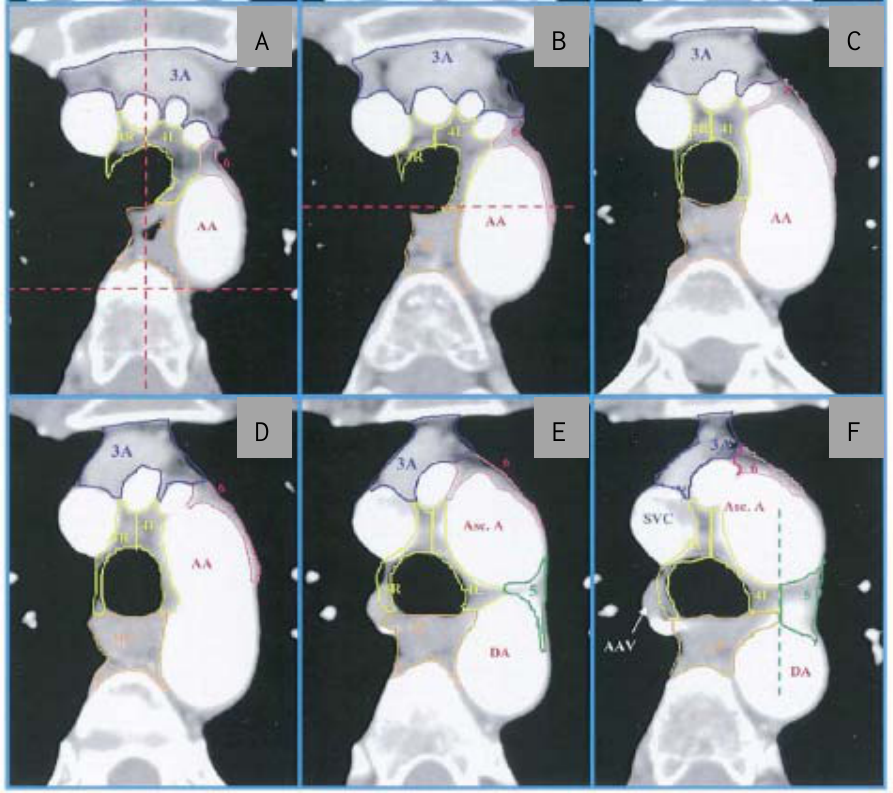
Figure 1. Thoracic atlas delineating lymph node stations from the University of Michigan (from Chapet et al . [23]). ( A – C ) Lymph node stations near level of sternal notch; ( D ) Superior aspect of aortic arch; ( E ) Level demonstrating posterior limit of 4R and 4L (red dotted line). ( F ) Level of left brachiocephalic vein, with delineation of 4L/3P and 5. AA = aortic arch; 3A = prevascular nodes; 3P = retrotracheal nodes; 4L/4R = lower paratracheal nodes; 5 = paraaortic nodes; 6 = paraaortic